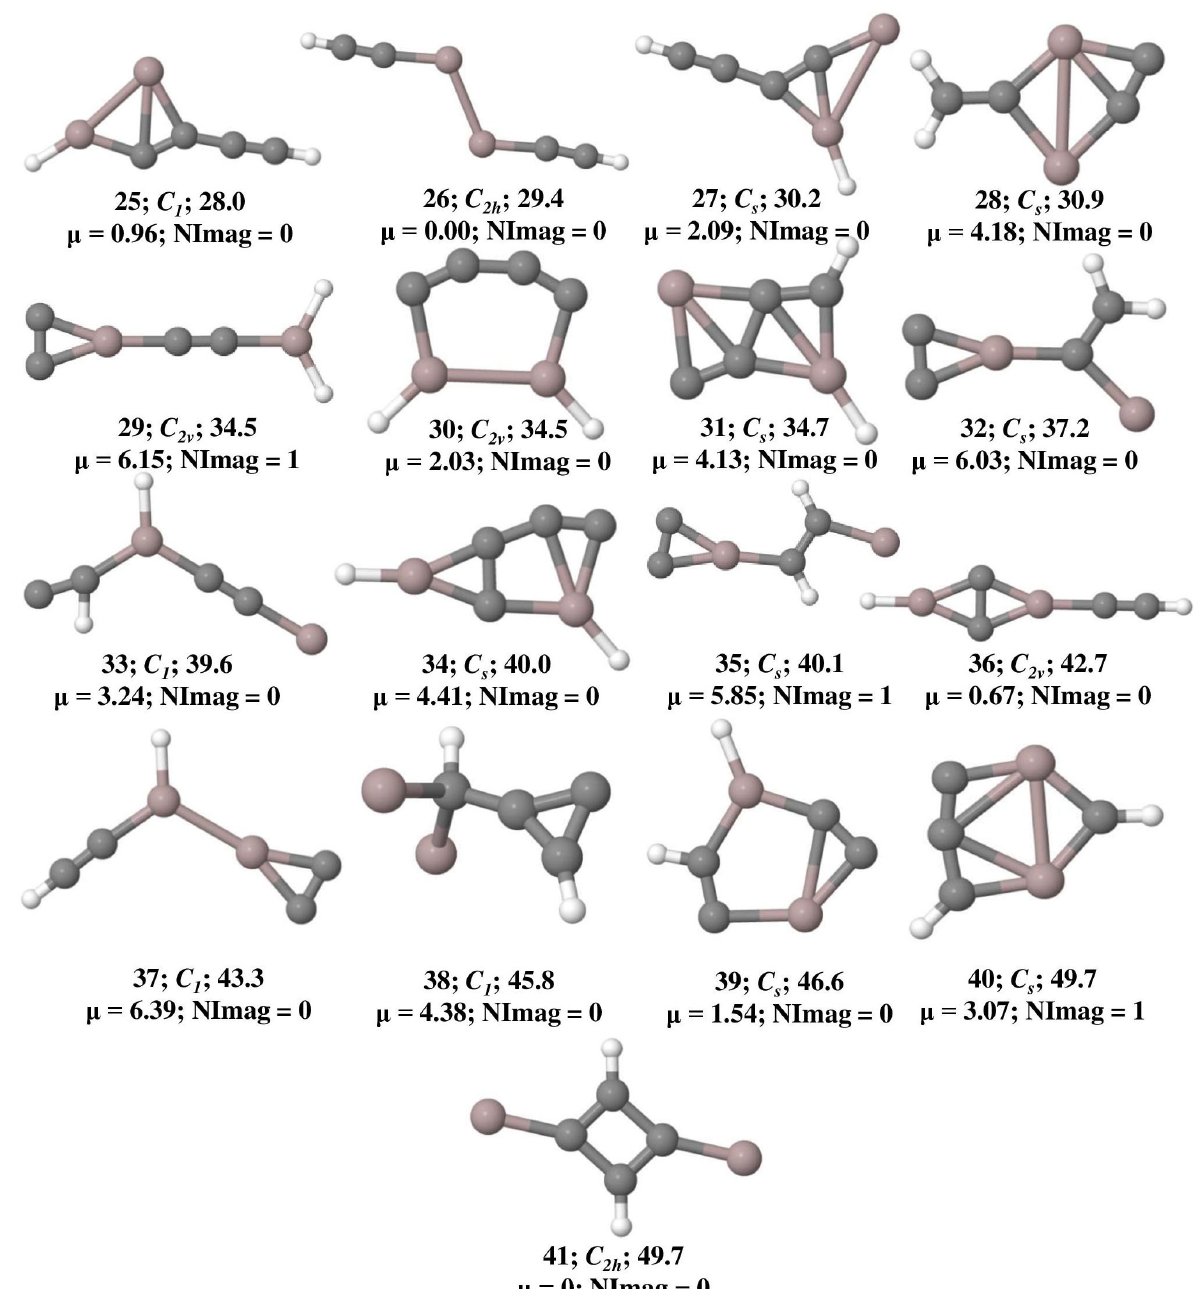
Figure 1. Isomers of Al 2 C 4 H 2 that lie within 50 kcal mol − 1 and their zero ‐ point vibrational energy (ZPVE) corrected relative energies (in kcal mol − 1 ), dipole moments (in Debye), and the number of imaginary frequencies (NImag) obtained at the ω B97XD/6 ‐ 311++G(2d,2p) level of theory.